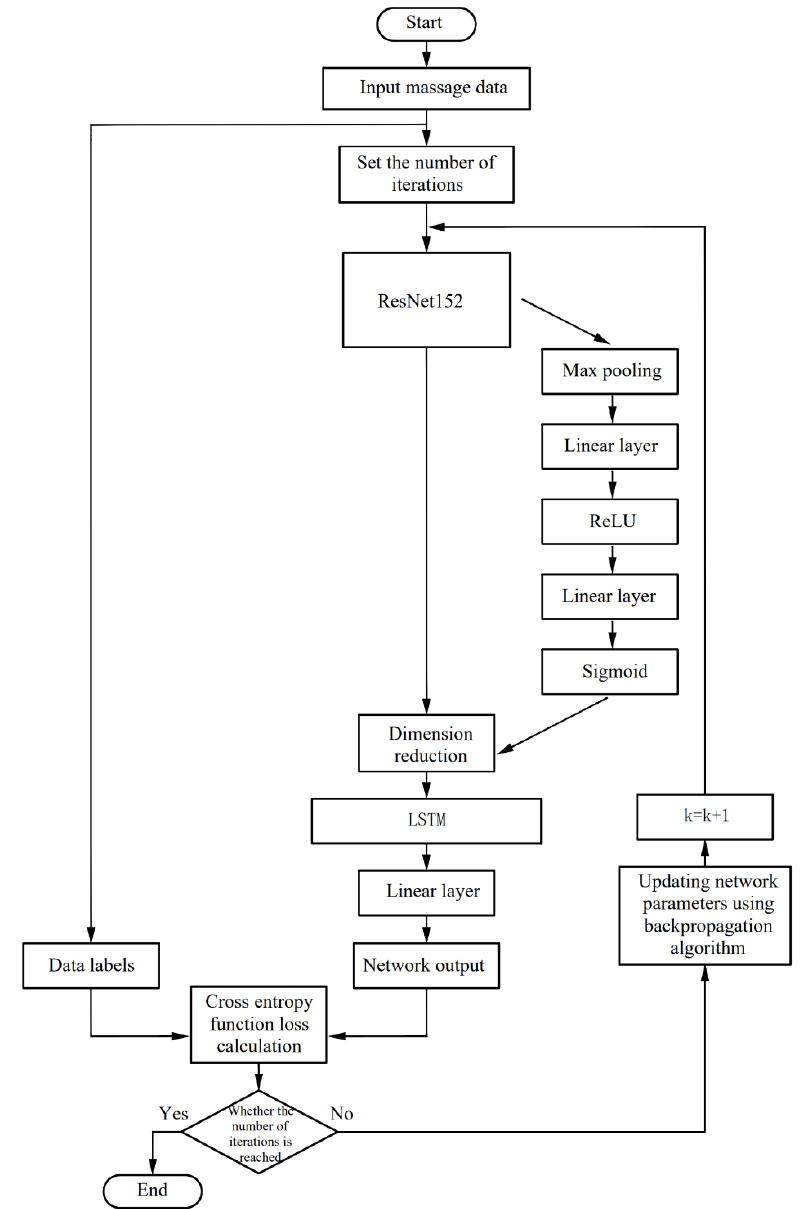
Figure 7. Algorithm flow chart of the network.